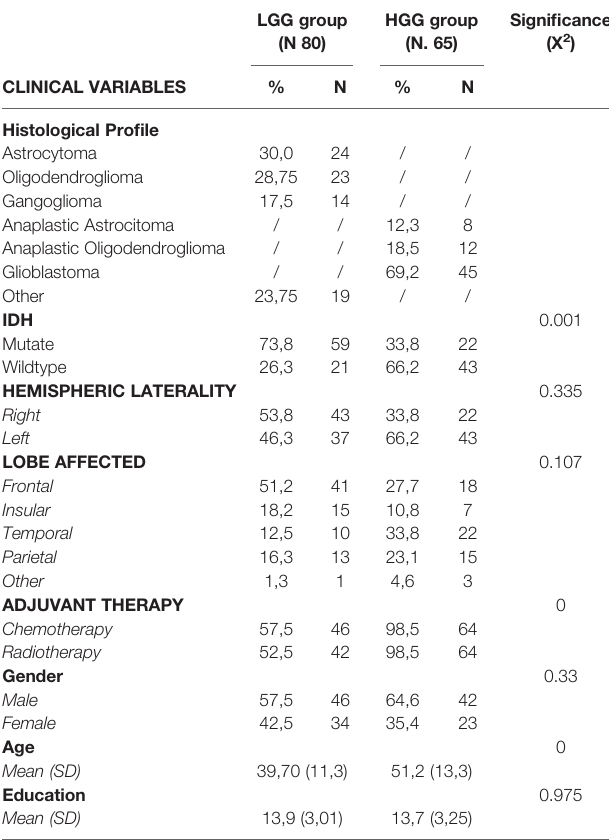
TABLE 1 | Frequency of the clinical and demographic characteristics of Lower (LGG) and High Grade Glioma (HGG) groups.